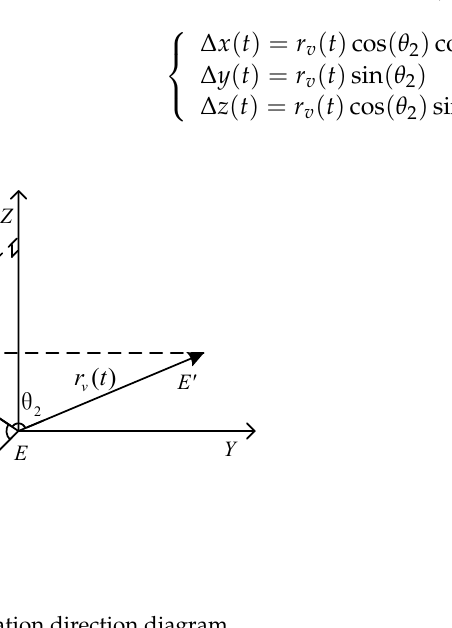
Figure 2. Vibration direction diagram.